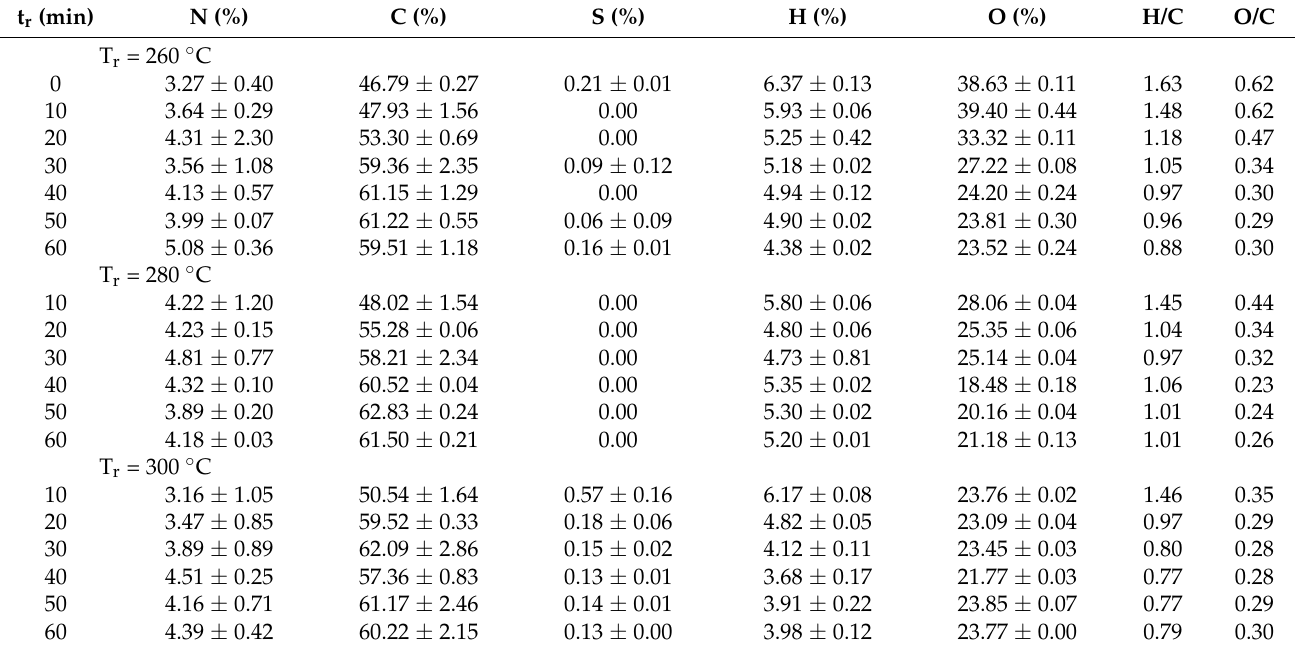
Table 1. Chemical elemental analyses of JMS at t r = 0 min and of torrefied JMS (JMS T